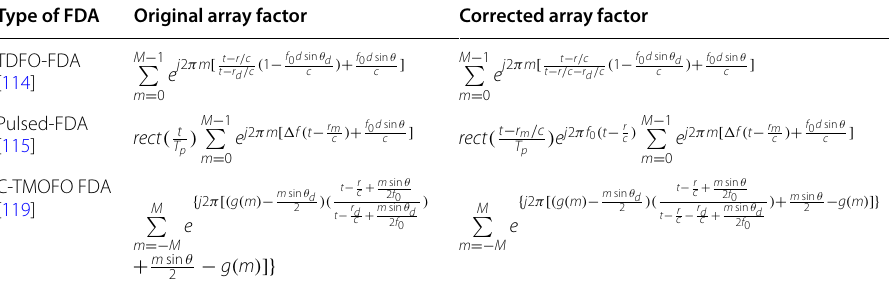
Table 1 Comparison of original and corrected FDA array factors Type of